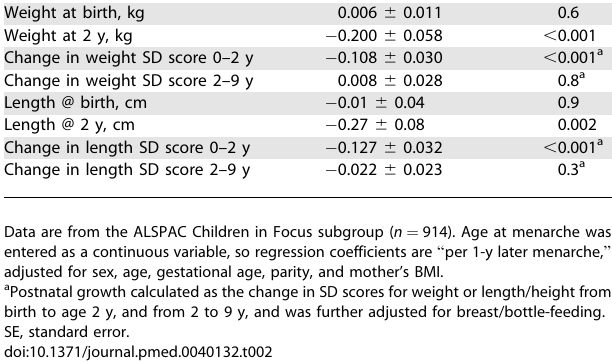
Table 2. Association between Mother’s Age at Menarche and Her Children’s Size at Birth and Postnatal Growth Variable Regression Coefficient 6